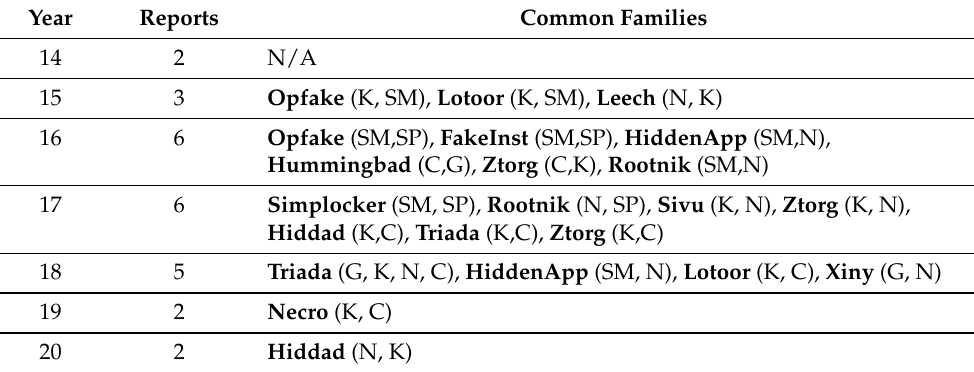
Table 2. Top common families found in Android threat intelligence reports 2014-2020. Reports column refers to total number of reports in that year. K: Kaspersky, SM: Symantec, N: Nokia, SP: Sophos, C: